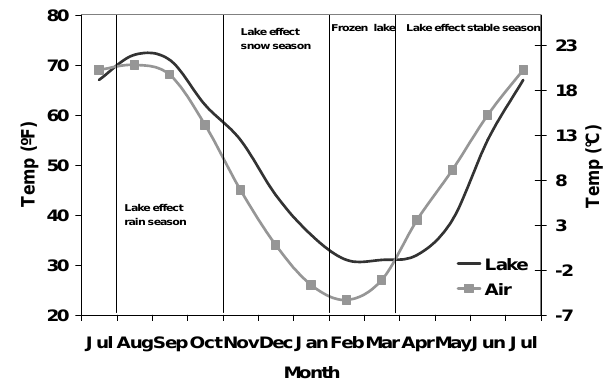
Figure 1. The mean air and Lake Erie temperatures at Bu ff alo, New York. Reproduced from Niziol et al. (1995).